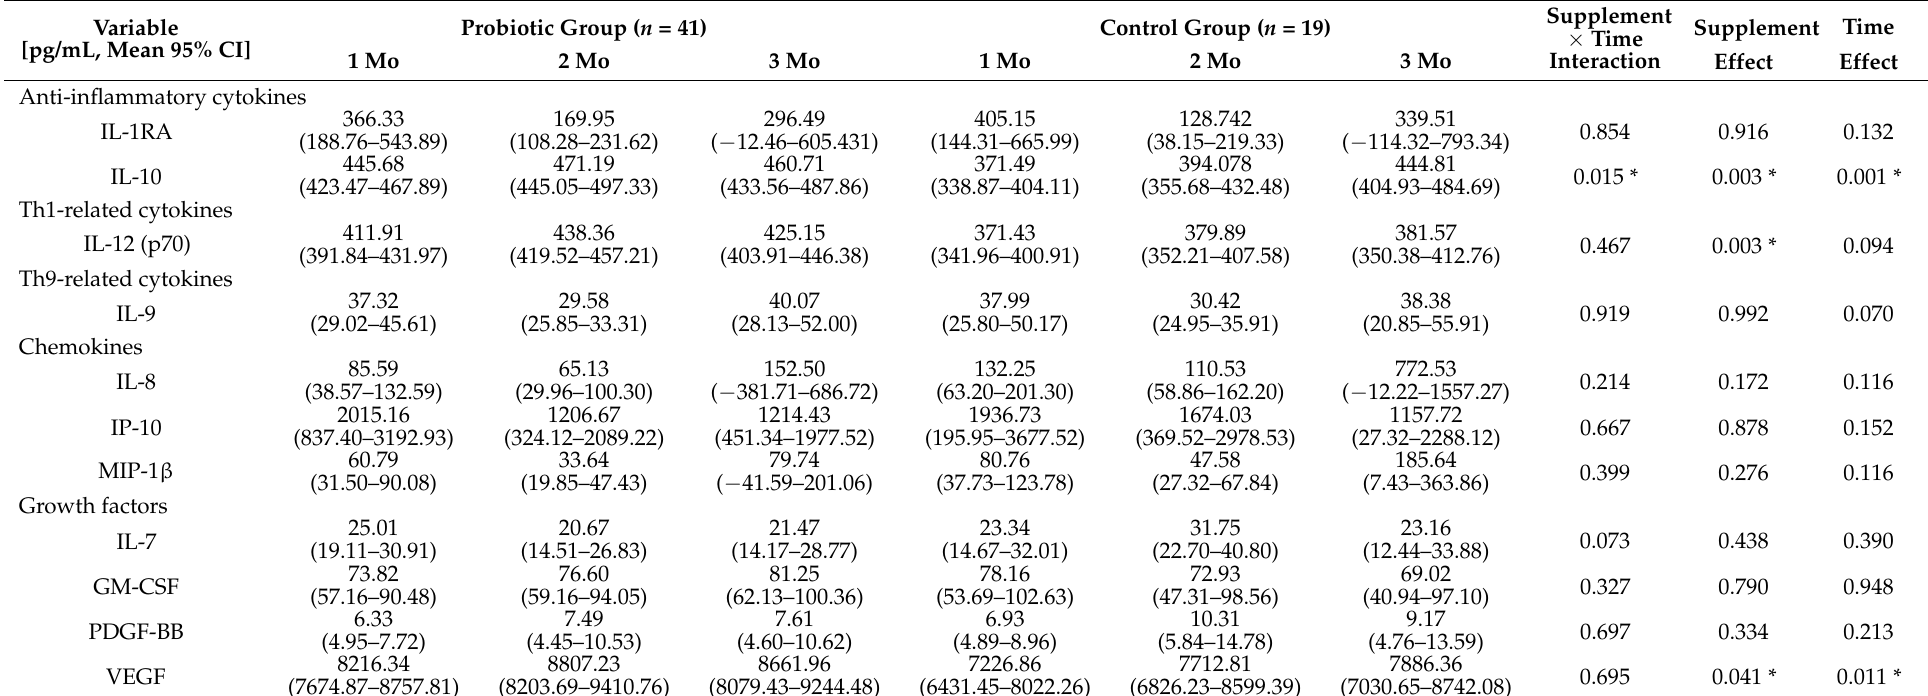
Table 4. Effects of probiotic supplementation on levels of